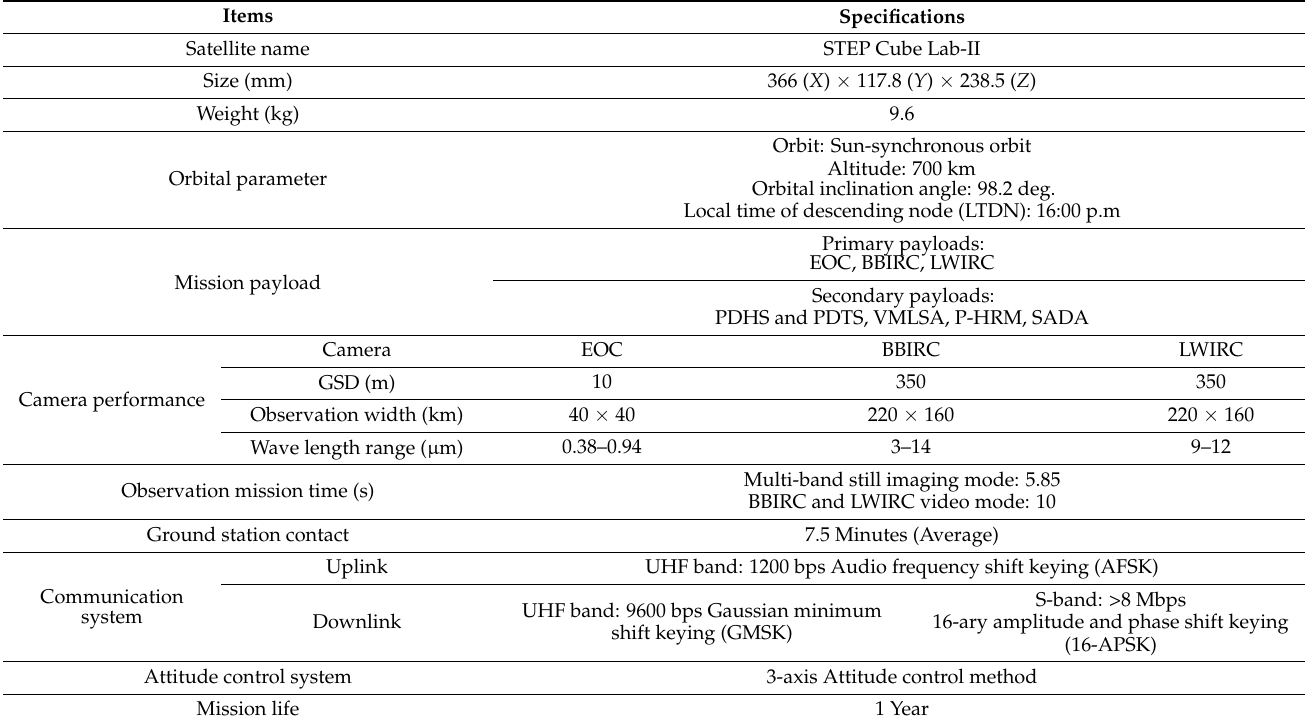
Table 1. Detailed system specifications of the STEP Cube